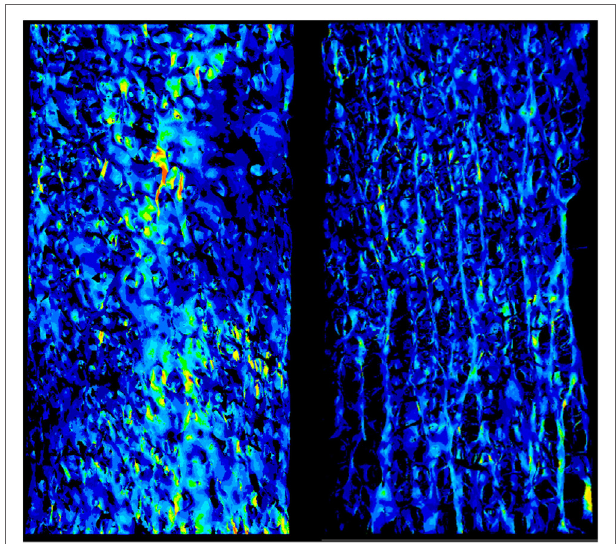
FigUre 1 | The strain field of two specimens is shown. It appears to be essentially homogeneous with punctual strain variations related to the complexity to the